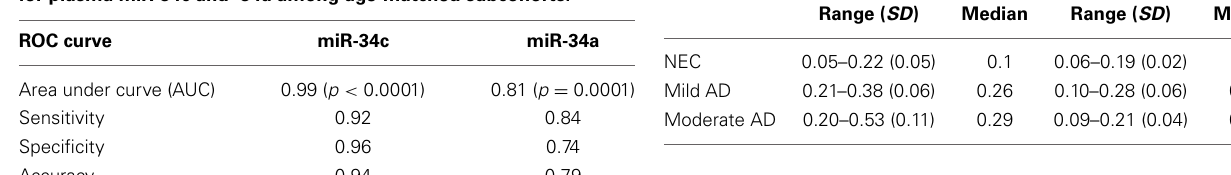
FIGURE 5 | Differential expression of miR-34c in plasma from patients with mild and moderate severity of Alzheimer’s disease (AD), compared with normal elderly controls (NEC) in age-matched cohorts. AD patients were grouped by mild and moderate severity according to their Mini-Mental Status Examination (MMSE) scores. (A) Percentile distribution of samples within the various stages of AD and NEC, plotted against inverse (cid:2) Ct for individuals of age-matched cohorts. The levels of miR-34c are higher in samples from moderate ( ) and mild ( ) clinical groups, with MMSE scores in the range of 10–20 or 21–24, respectively, than NEC ( ) controls in the range of 25–30. (B) Data points added to illustrate the distribution of individuals within each group of the age-matched cohorts. FIGURE 4 | Receiver Operation Characteristic (ROC) curves We observe NEC to be in a close cluster around the median, whereas AD representing AD diagnostic tests by miR-34c and miR-34a in patients are scattered in a wider range in both moderate and mild groups. age-matched cohorts. The Receiver Operation Characteristic (ROC) curve Both the LSD test (higher type 1 Error) and the Scheffé test (higher ….. ) is an excellent test since the area under the curve is 0.99 for miR-34c ( stringency) were used to determine statistical significance. The statistical ( p < 0 . 0001), number of samples for AD = 25 and NEC = 27. The area significance level for the LSD test is represented with the symbol ( ) , and ---- for Scheffé test is represented with the symbol ( ∗ ). is under the Receiver Operation Characteristic (ROC) for miR-34a ( ) 0.81 ( p = 0 . 0001) which is a good/fair test, number of samples for AD = 25 and NEC = 27. Sensitivity and specificity are reported based on a cut-off point chosen using the coordinates of Receiver Operation Characteristic Table 5 | 1/deltaCt levels of plasma miR-34c and -34a by clinical (ROC) curves with balanced levels of high sensitivity and specificity. The category of mild and moderate Alzheimer’s disease (AD) and in diagonal line represents a reference line showing zero sensitivity and zero age-matched normal elderly controls (NEC): range with standard specificity ( ) . deviation ( SD ) and Table 4 | Receiver Operating Characteristic (ROC) curve parameters for plasma miR-34c and -34a among age-matched subcohorts.